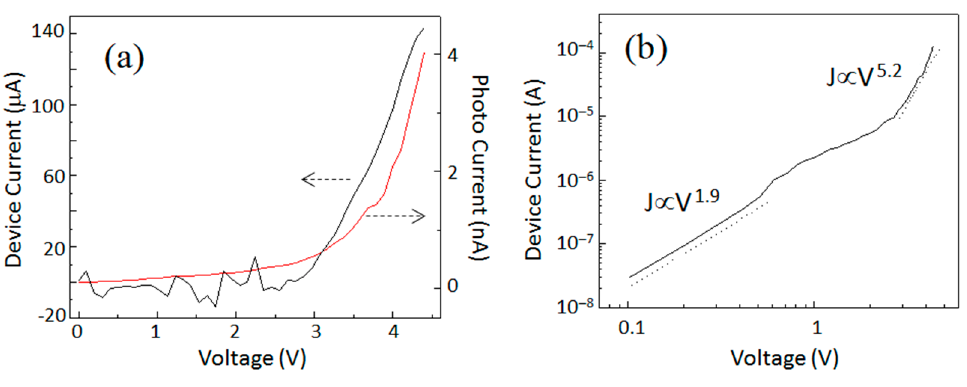
Figure 2. ( a ) Device I–V characteristics (black-curve) and photodiode I–V characteristics (red-curve) and ( b ) I–V in double log scale to fit linearly with a different slope (as guided by the dotted line).